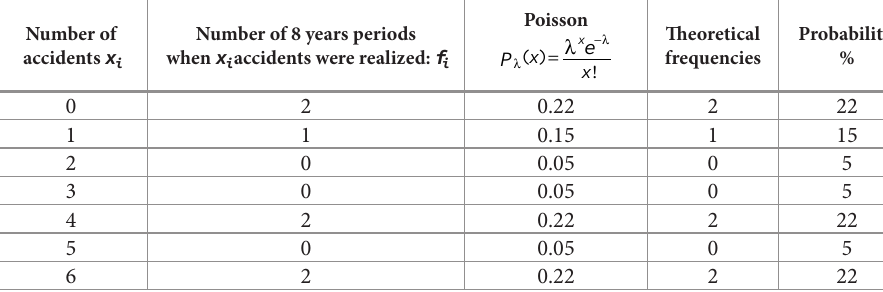
Table 10. Sample of accident frequency based on poisson distribution Number of accidents x